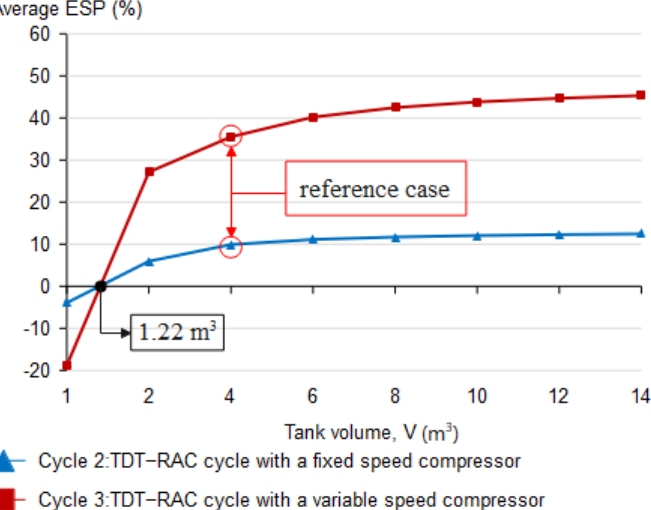
Figure 9. Average ESP versus day time ambient temperature (the threshold of both TDT-RAC curves is the same, which is about 1.22 m 3 ).